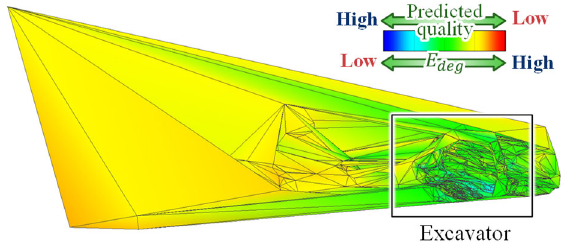
Figure 11. Sparse point clouds and camera poses of the construction site.